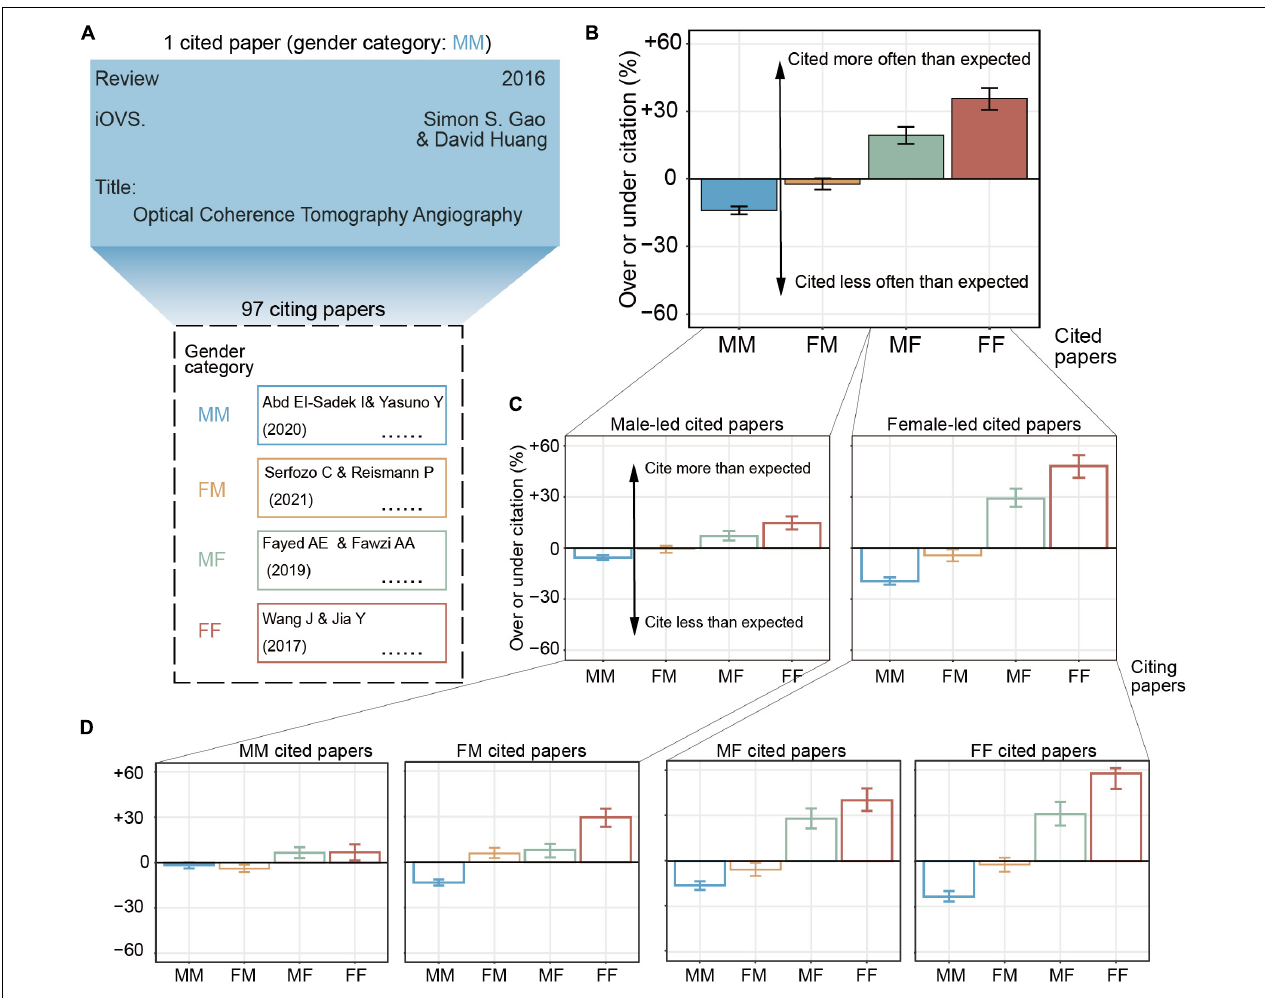
FIGURE 2 | The gender gap in citation counts. (A) Definition of cited paper and citing papers. Gender category of a given paper is defined by the gender of the first and last author. In the example we provide here, a review paper from Dr. Simon was published in iOVS in 2016. We defined it as an MM cited paper using the GenderAPI database. This cited paper has been cited by 97 citing papers. (B) The degree of over- or under-citation of different gender category of cited paper. MM papers were cited 9.3% less than expected (95% CI, –10.6 to –8.0%), FM papers were cited 1.5% less than expected (95% CI, –3.1 to 0.5%), MF papers were cited 13.0% more than expected (95% CI, 10.5–15.2%), and FF papers were cited 23.9% more than expected (95% CI, 20.5–27.2%). (C) The degree of over- or under-citation after separating cited papers by the more common (i.e., led) gender and (D) by full gender. Bars represent overall over-citation and under-citation, calculated from 53,962 total citation counts (MM, 24,058, FM, 13,742, MF, 8,384, and FF, 7,778). Error bars represent the 95% of CI of each citation estimate, calculated from 1,000 bootstrap resampling